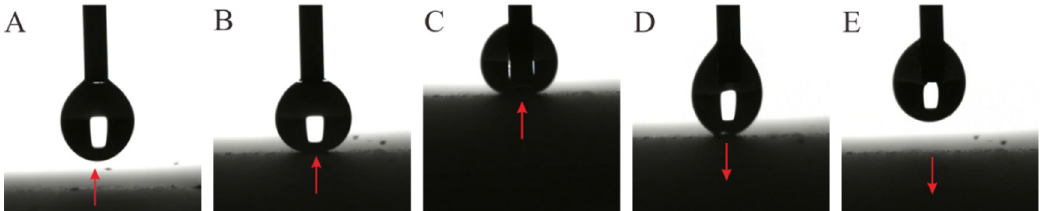
Figure 5. The experimental process diagram of the surface adhesion of the polished base coating. ( A ~ C ) The process of moving up the test bed; ( D , E ) the process of moving down the test bed.